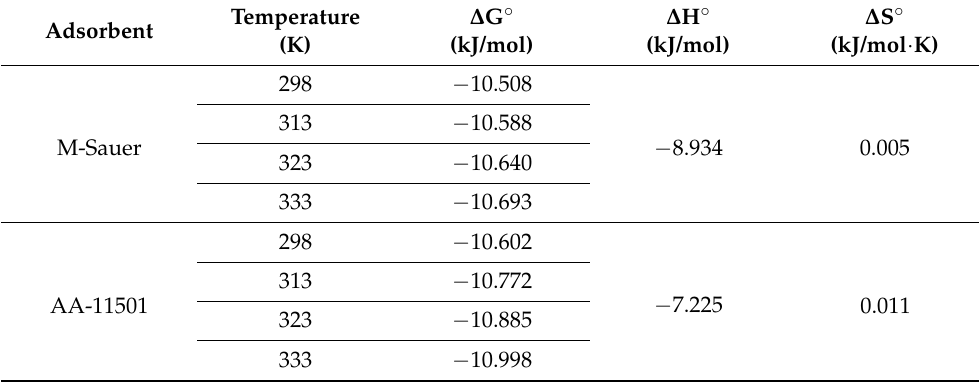
Table 1. Thermodynamic parameters for the sorption of CA- 99 Mo on different alumina adsorbents.